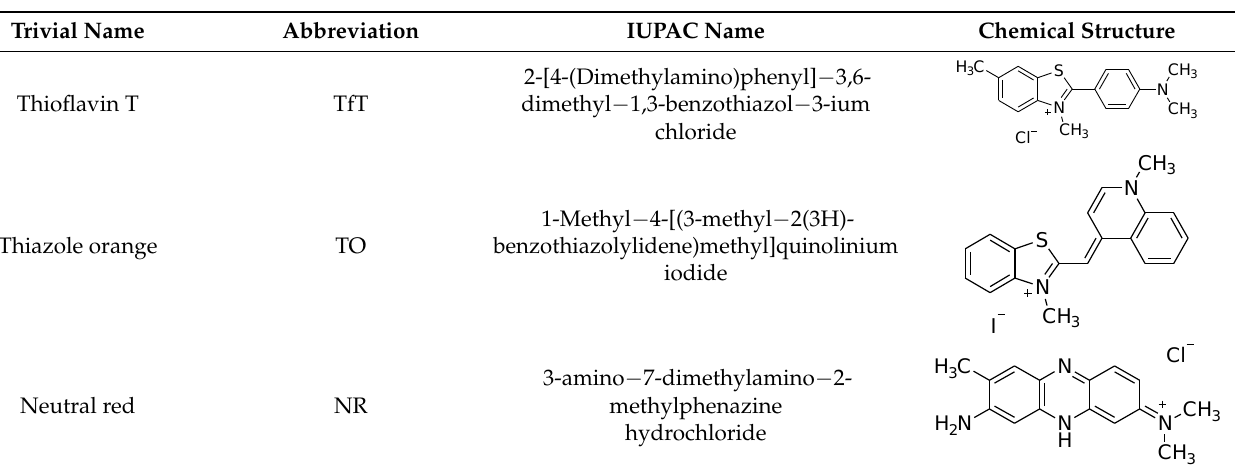
Table 1. Names and chemical structures of the fluorogenic dyes used in the current study (without the counter ion).